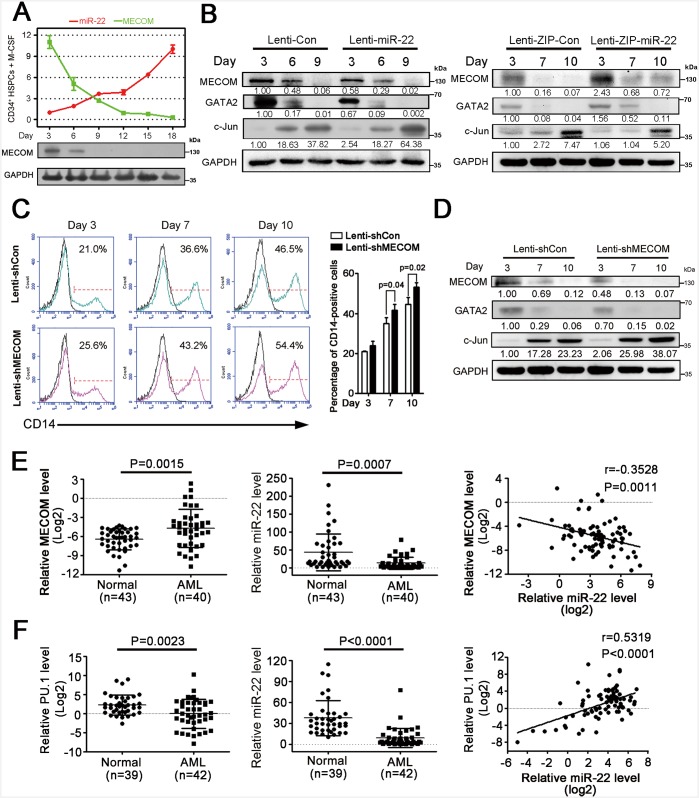
Verification that miR-22 regulates the differentiation of human HSPCs via MECOM, as well as association analyses between miR-22 and MECOM and between PU.1 and miR-22 expression in AML patients.The collection of HCB CD34+ HSPCs, as well as their infection with Lenti-miR-22 or Lenti-ZIP-miR-22 or a relative control, monocyte/macrophage induction culture, and differentiation assays have been described in the legend of Fig 3. A. Analysis of miR-22 and MECOM mRNA via qRT-PCR as well as Western blot analysis of MECOM protein levels in the monocyte/macrophage induction culture of HCB CD34+ HSPCs (representative; n = 2). B. Western blot analyses of MECOM, GATA2 and c-Jun expression in the induction culture of CD34+ HSPCs infected with Lenti-miR-22, Lenti-ZIP-miR-22 or a relative control. A representative experiment is presented (n = 2). C. The MECOM knockdown promoted monocyte/macrophage differentiation of CD34+ HSPCs. The CD34+ HSPCs were infected with a recombinant lentivirus expressing shRNAs targeting MECOM mRNA (Lenti-shMECOM) or Lenti-shCon, cultured in a monocyte/macrophage induction medium and harvested on the indicated days. Flow cytometry assays demonstrated an increased percentage of CD14-positive cells in the Lenti-shMECOM infection group. A representative experiment is presented on the left, and a statistical analysis for the two experiments is presented in the right (Error bars represent SD). The black-line curve represents the unstained cells. D. Immunoblotting of MECOM, GATA2 and c-Jun levels in the above cells (representative; n = 2). E. MECOM mRNA analysis via qRT-PCR and correlation analysis with the miR-22 levels in the PBMNCs from AML patients and normal donors. MECOM mRNA was detected by Taqman qRT-PCR. F. qRT-PCR of PU.1 mRNA and correlation analysis with miR-22 levels in the PBMNCs from AML patients and normal donors. The Pearson correlation coefficient r was calculated and verified by the two-tailed significance test.